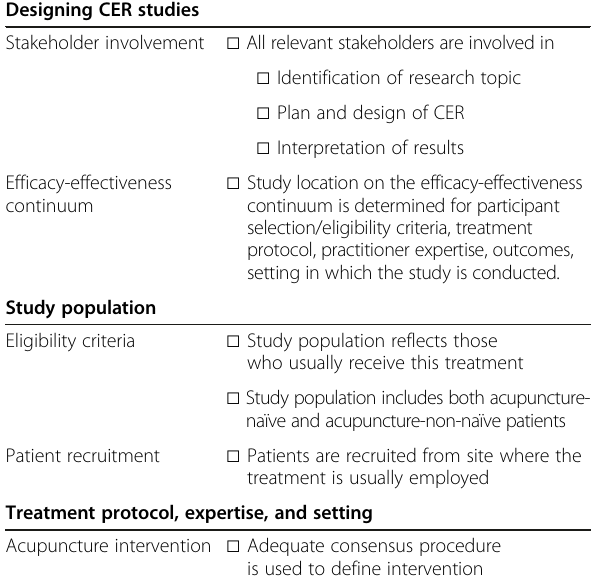
Table 1 Checklist for CER relevant aspects for acupuncture clinical studies Designing CER studies